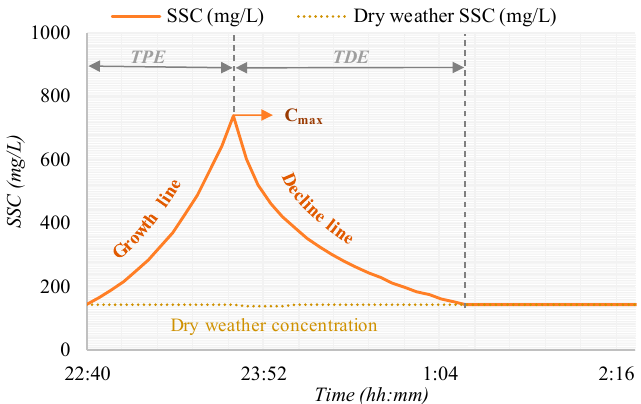
Figure 4. Methodology proposed to calculate the suspended sediment concentration, SSC, during a flood event (Garcia et al.